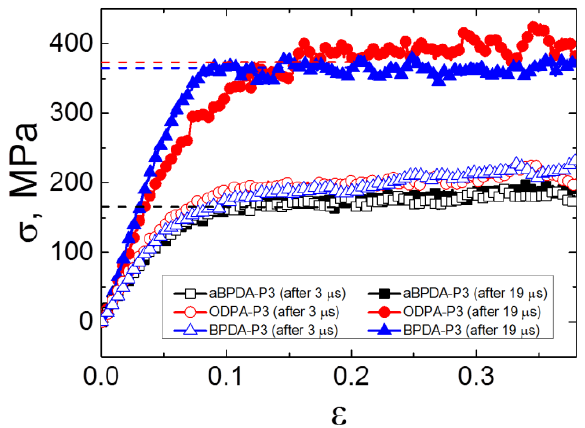
Figure 6. The stress-strain dependence for the simulated nanocomposites based on ODPA-P3, aBPDA-P3, and BPDA-P3 polyimides after 3 and 19 μs of simulation. The dashed lines indicate the yield stress values of considered nanocomposites after 19 μs of simulation.